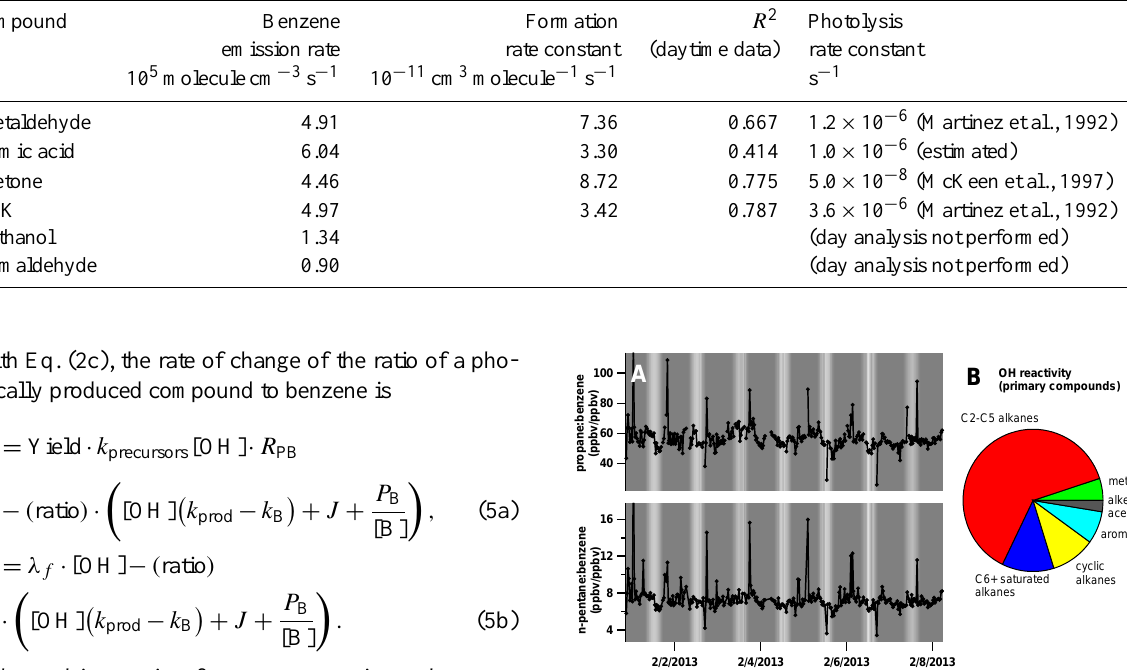
Table 3. Oxygenated compound results. Compound